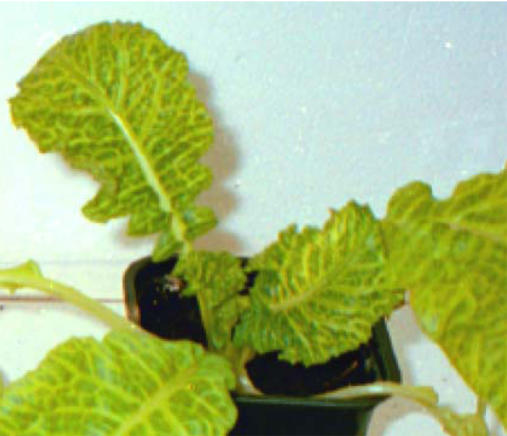
Turnip infected by cauliflower mosaic virus